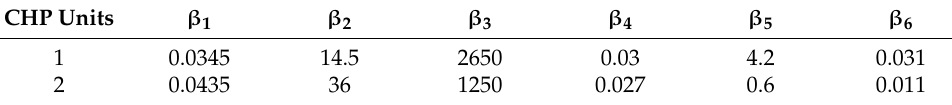
Table A2. Cost coefficients of the CHP units.